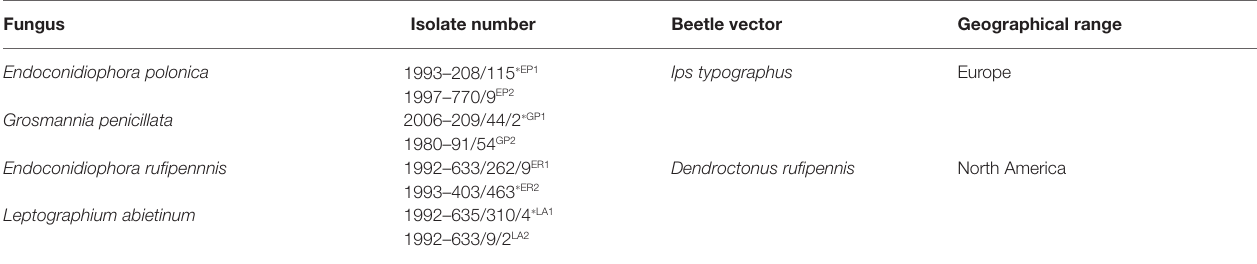
TABLE 1 | Species of bark beetle-associated fungi inoculated in cut bolts of Norway spruce, black spruce, and white spruce. Fungus Isolate number Beetle